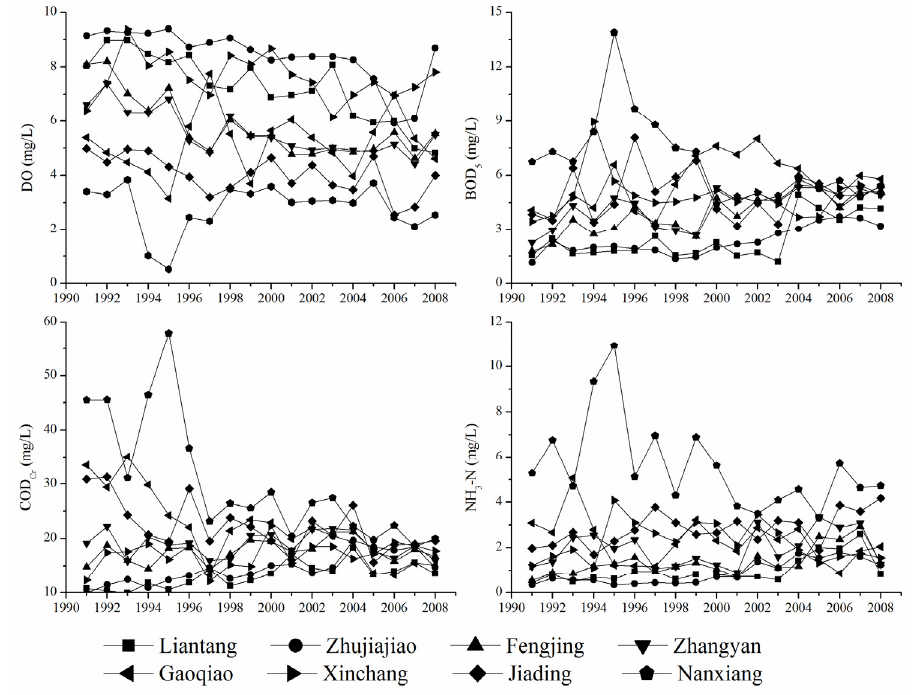
Figure 2. Water quality status of river network around sampling sites in